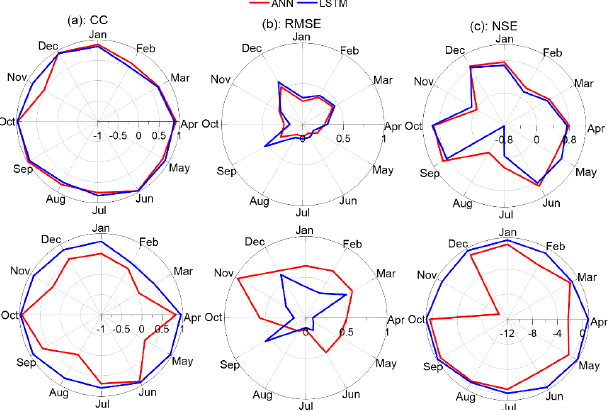
Figure 6. Monthly evaluation results. ( a – c ) show the statistical metrics (CC, RMSE, and NSE) for layer 4. The first and second lows represent monthly evaluation results for lead times of 1 and 6 days of lead times.